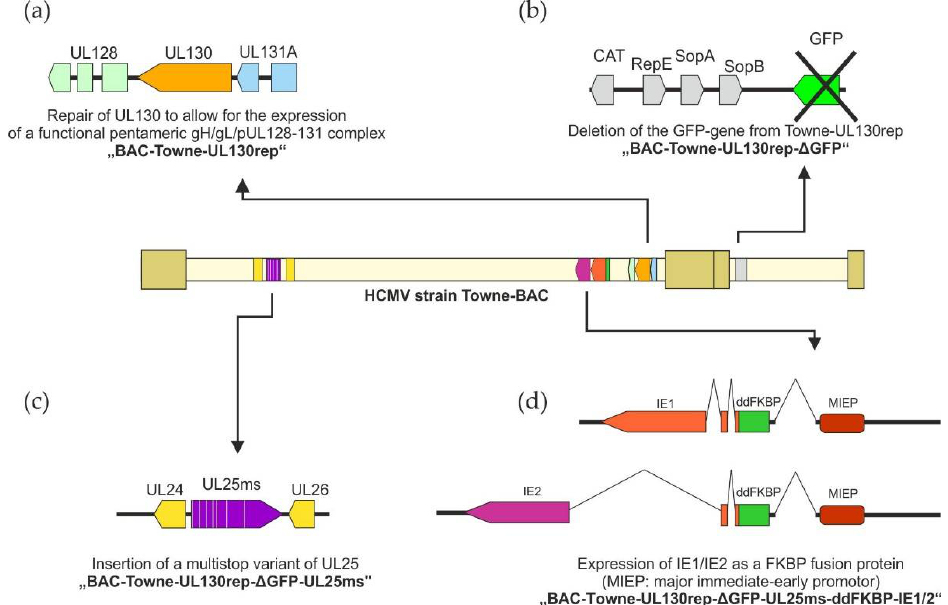
Figure 1. Schematic representation of the cloning strategy of TR-VAC with HCMV Towne-BAC as parental strain [49,50] . All cloning steps were performed using the GalK positive/negative selection system. ( a ) Replacement of the mutated UL130 gene of strain Towne by the respective functional sequence of strain TB40/e resulted in the generation of BAC-Towne-UL130rep [23] . ( b ) Removal of the GFP-coding resulted in the generation of BAC-Towne-UL130rep-ΔGFP [16] . ( c ) Replacement of the UL25 coding sequence by a multi-stop variant of the gene resulting in the generation of BAC-Towne-UL130rep-ΔGFP-UL25ms (see Figure S1). ( d ) Insertion of the ddFKBP destabilizing domain in frame with the UL123/122 open reading frames, encoding HCMV IE1 and IE2 resulting in BAC- Towne-UL130rep-ΔGFP-UL25ms-ddFKBP-IE1/2. Transfection of the latter BAC on HFF resulted in the establishment of strain TR-VAC.